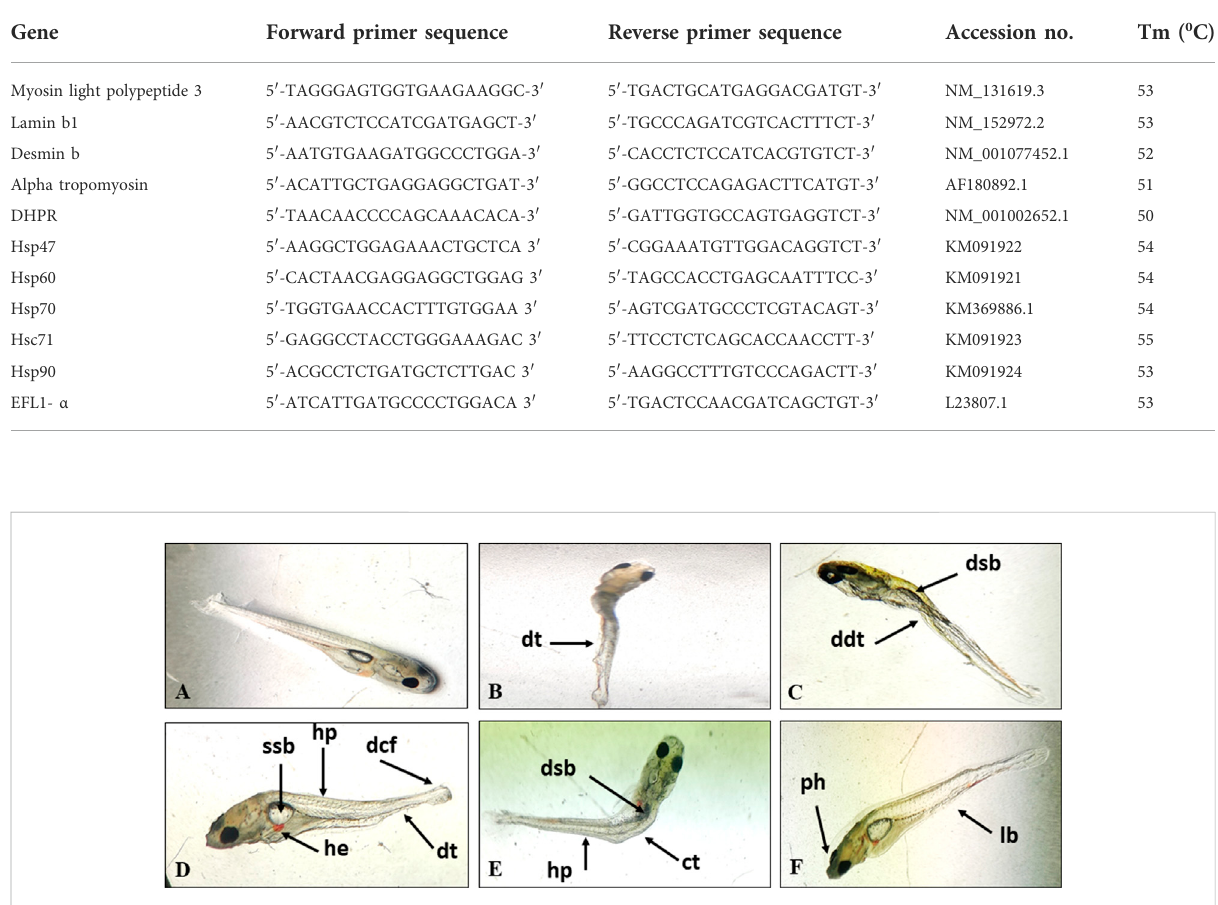
TABLE 1 Primer sequences, accession numbers and optimum annealing temperatures for various genes.